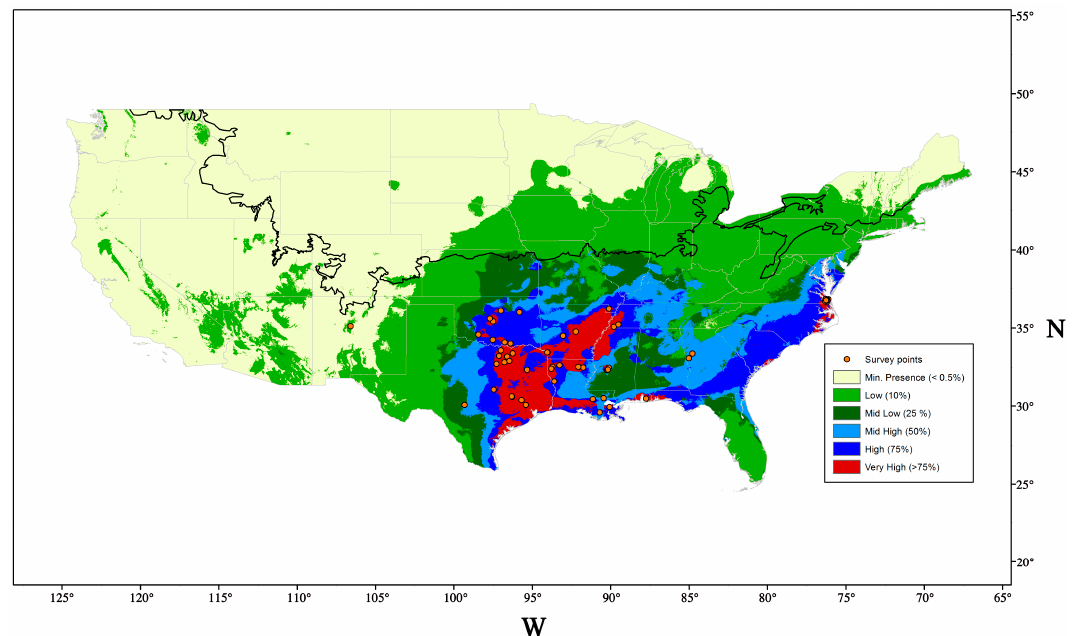
Figure 3. Projected distribution of Acanthococcus lagerstroemiae in the U.S. Warmer color indicates the higher climatic suitability. Orange points indicate the location of reported infestation. The black line indicates the upper limit of Plant Hardiness Zone 6.